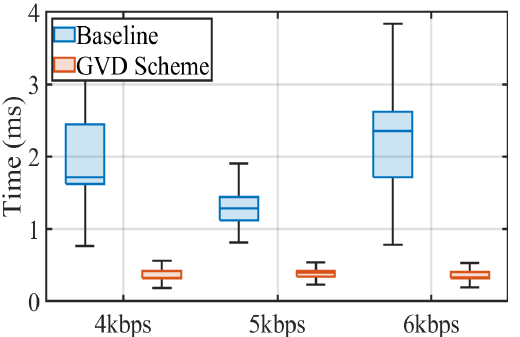
Figure 7. RoI extraction performance under variable transmission frequencies.